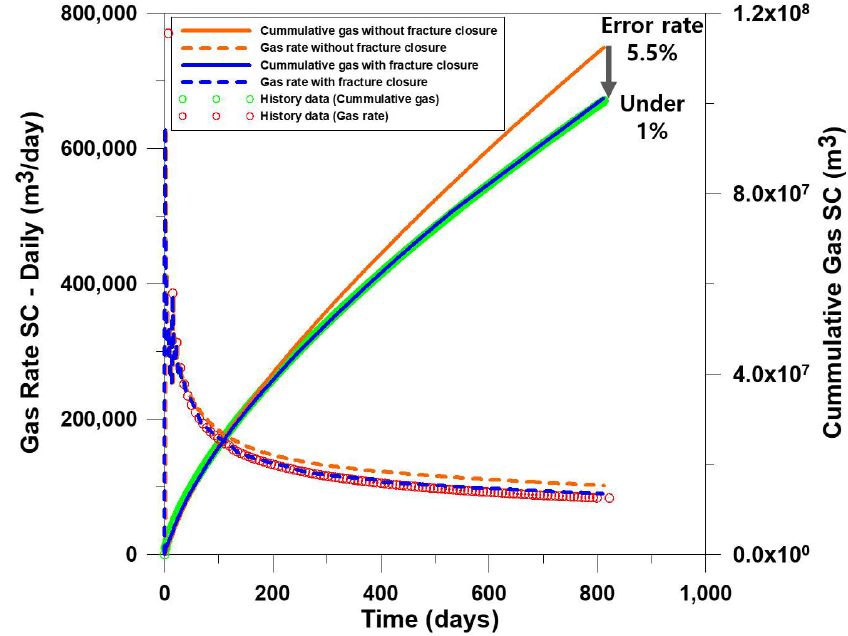
Figure 17. Comparison of production history matching results with consideration of changes in fracture width.